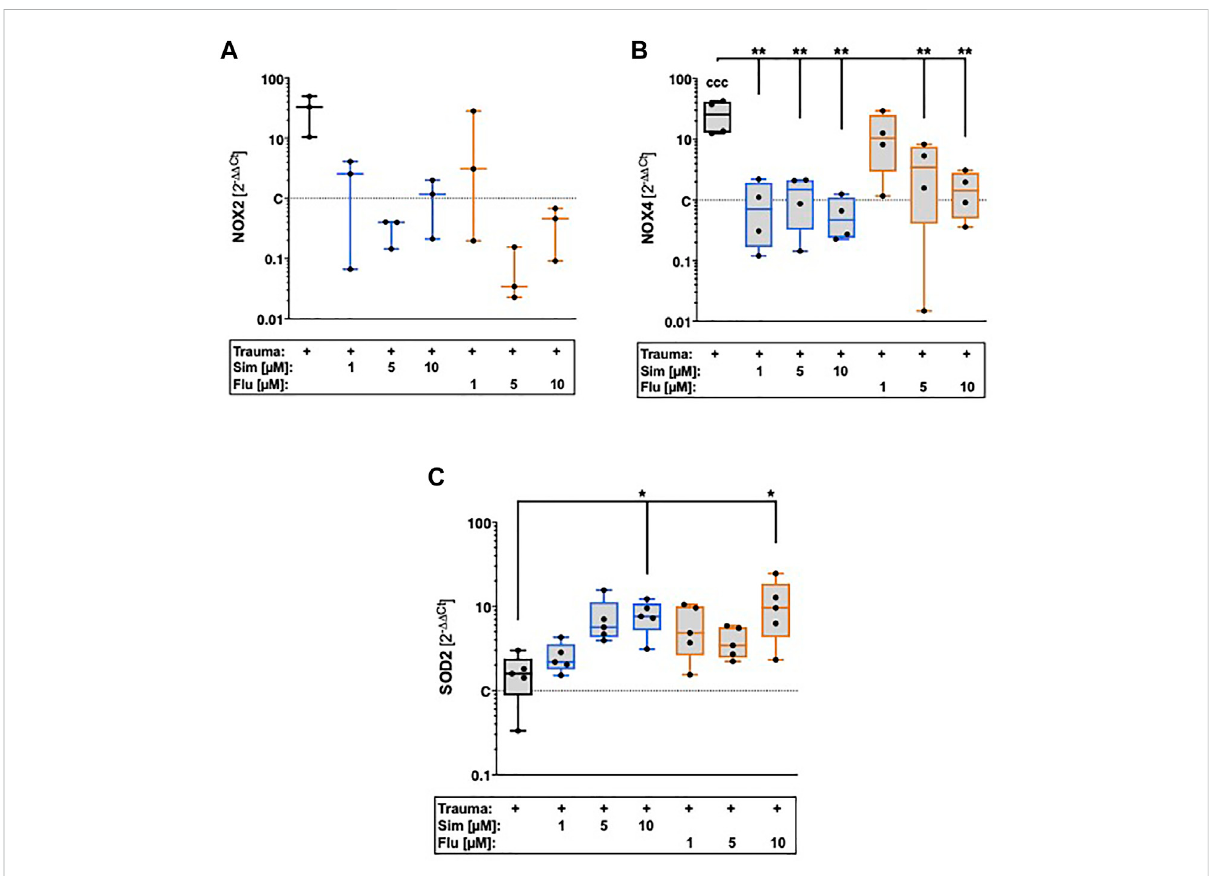
FIGURE 5 Effects of statin treatment on gene expression of NADPH oxidases and SOD2 after cartilage trauma. Potential effects of statins on intracellular oxidative stresswere determined by meansof geneexpression analysisof (A) NOX2 (B) NOX4 and (C) SOD2. Signi fi cantdifferences betweengroups were depicted as [versus T] * = p < 0.05, ** = p < 0.01 [versus C] ccc = p < 0.001; n ≥ 3. Shaded boxes = traumatized cartilage explants